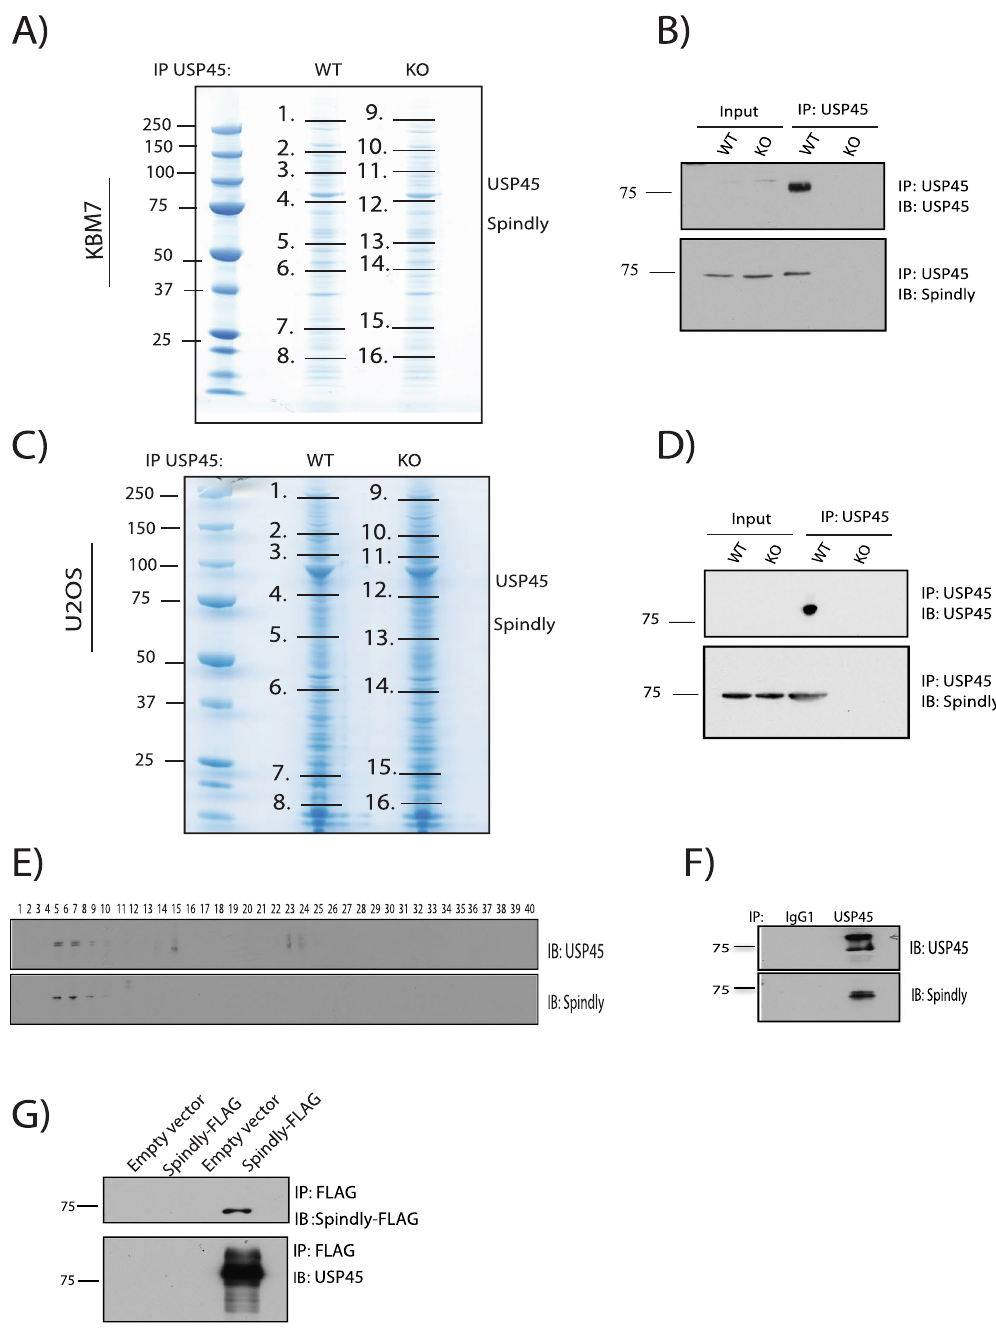
Figure 1. USP45 co-immunoprecipitates Spindly. ( A ) Endogenous USP45 was immunoprecipitated (IP) from wild-type (WT) or knock-out (KO) KBM7 cell lines. The immunoprecipitates were resolved on a polyacrylamide gel and stained with Coomassie. The gel was divided into the indicated sections (black lines) and proteins were identified by mass spectrometry analysis. ( B ) Endogenous USP45 was immunoprecipitated from WT or USP45 KO KBM7 cell lines and subjected to immunoblotting with indicated antibodies. ( C ) Endogenous USP45 was immunoprecipitated from WT and USP45 KO U2OS cell lines and analysed as in ( A ). ( D ) Endogenous USP45 was immunoprecipitated from WT or USP45 KO U2OS cell lines and subjected to immunoblotting with indicated antibodies. ( E ) Extracts of HEK293 cells were analysed by gel filtration on a Superdex 200 10/300 GL preparative grade column (GE Healthcare) in buffer containing 0.15 M NaCl, and every second fraction from 80 fractions obtained were denatured and analysed by immunoblotting with the indicated antibodies. ( F ) Fractions (5–10) of gel filtration analysis were used to immunoprecipitated endogenous USP45 and subjected to immunoblotting with the indicated antibodies. ( G ) Extracts of HEK293 overexpressing Spindly-FLAG were subjected to immunoprecipitation anti-FLAG and 10% of the immunoprecipitated proteins were analysed by immunoblotting for anti-FLAG and 90% for endogenous USP45. ( A – G ) All experiments were performed at least three times and a representative example is